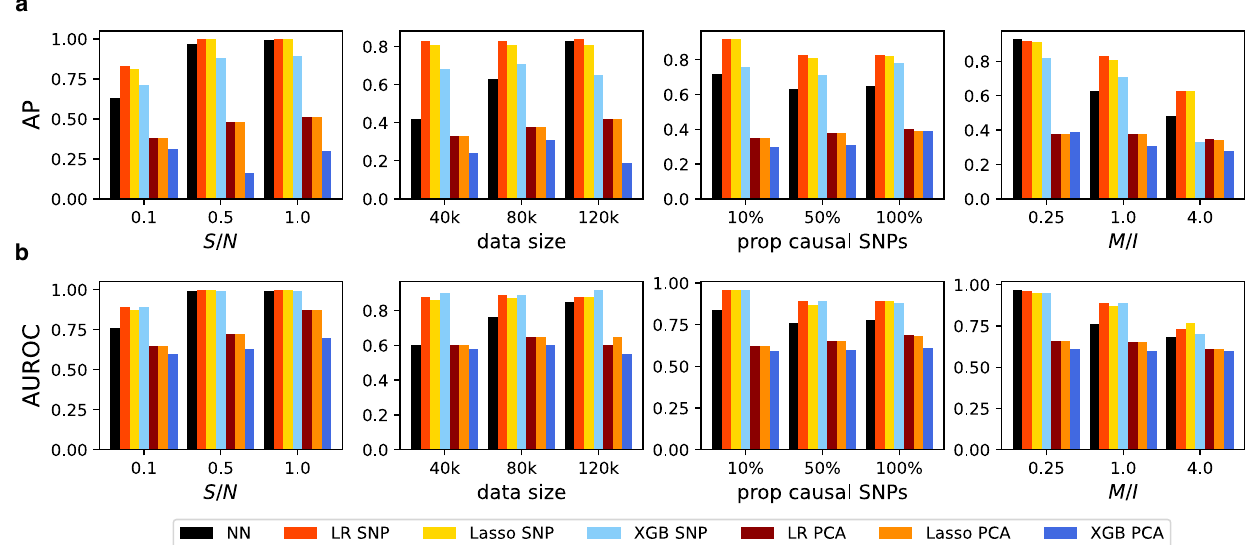
Fig. 4 Gene – gene interaction detection on simulation datasets with simple interactions. We show the average precision (AP) and AUROC of each gene – gene interaction detection methods on simulation datasets with different con fi gurations on panel ( a ) and panel ( b ) respectively. We simulate data using S/N = 0.1, datasize = 80 k , prop causal SNPs = 50%, and M/I = 1.0. We vary one hyper-parameter at a time while fi xing others to the speci fi ed values (each panel). Methods that use the top-SNP approach to represent genes are usually better than others, including